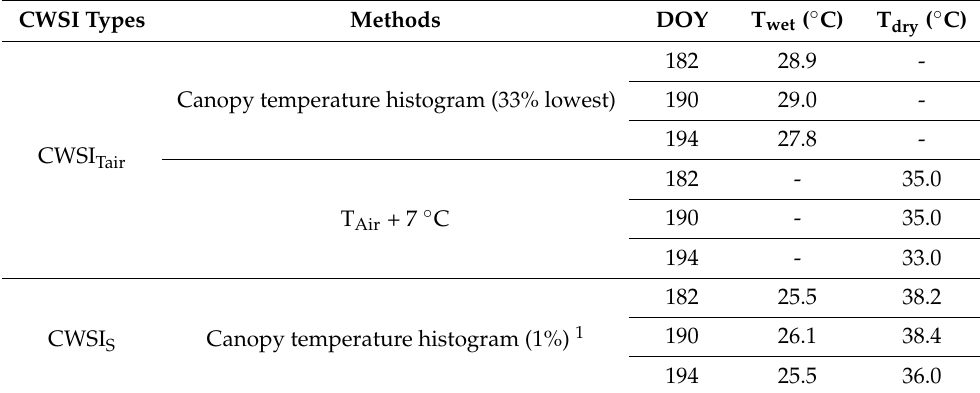
Table 2. Different methods of calculating T wet and T dry by